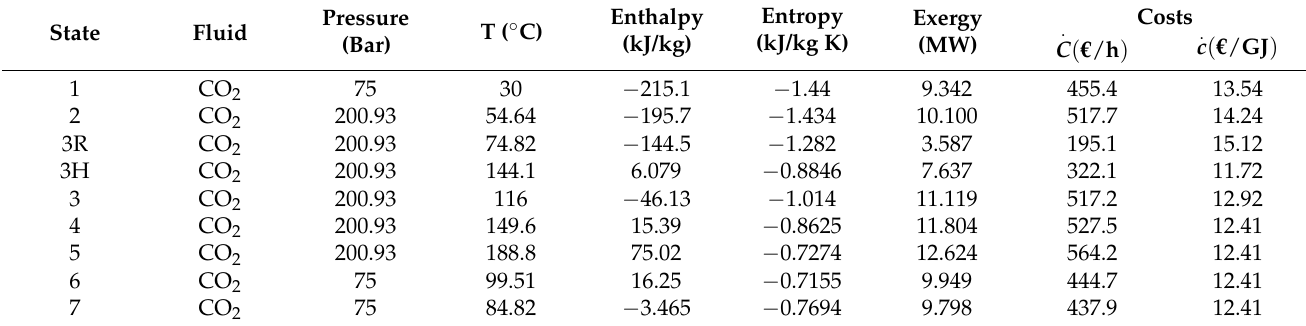
Table 10. Cost of Exergy Streams of Split